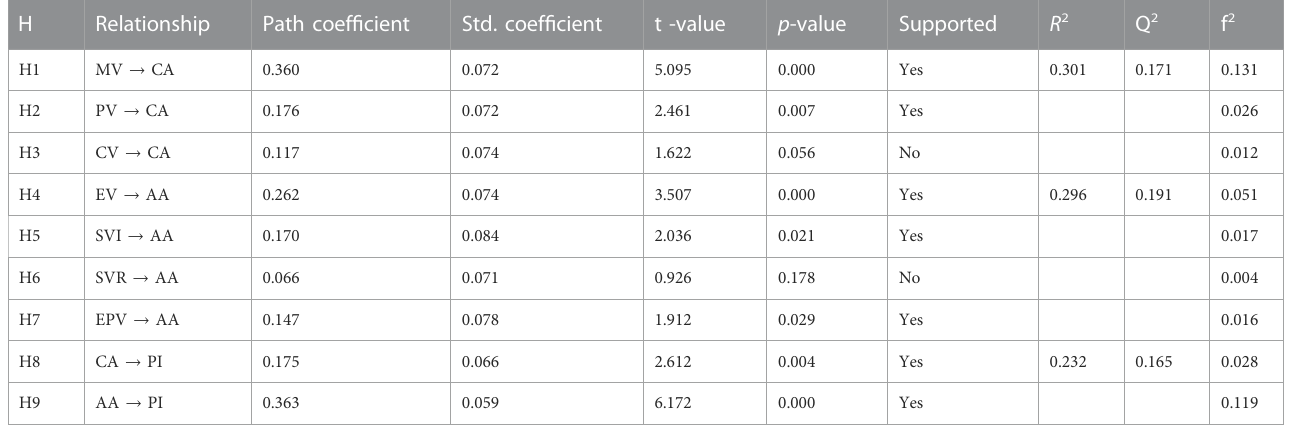
TABLE 5 Structural Model Results (Hypothesis